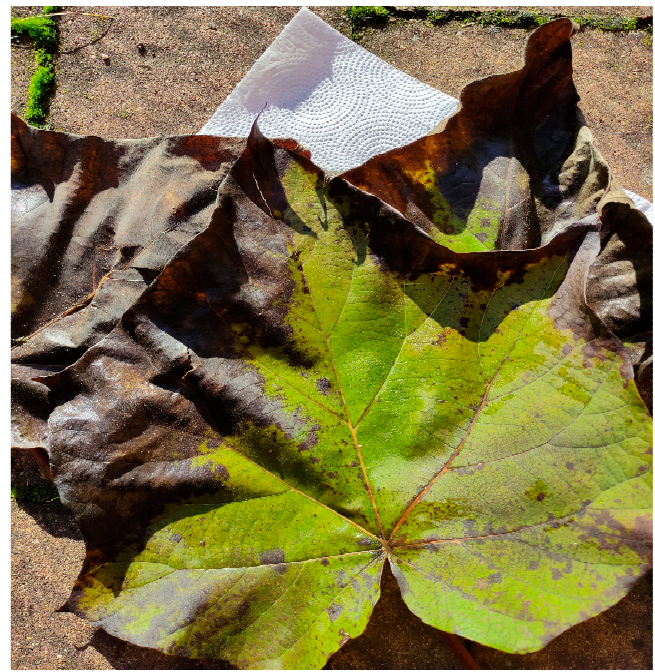
Figure 4. Pictures of leaves from the harvest “Collected (1 week)”.